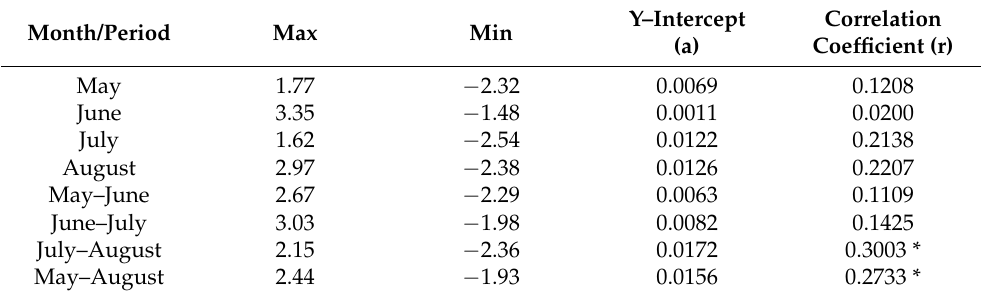
Figure 3. Variability over time of the meteorological drought index (SPI) during the period of active plant growth and development (May–August) in the region of Bydgoszcz in 1961–2020. Table 3. Extreme values and regression equations characterizing changes in SPI values in the period 1961–2020 with correlation coefficients characterizing a linear